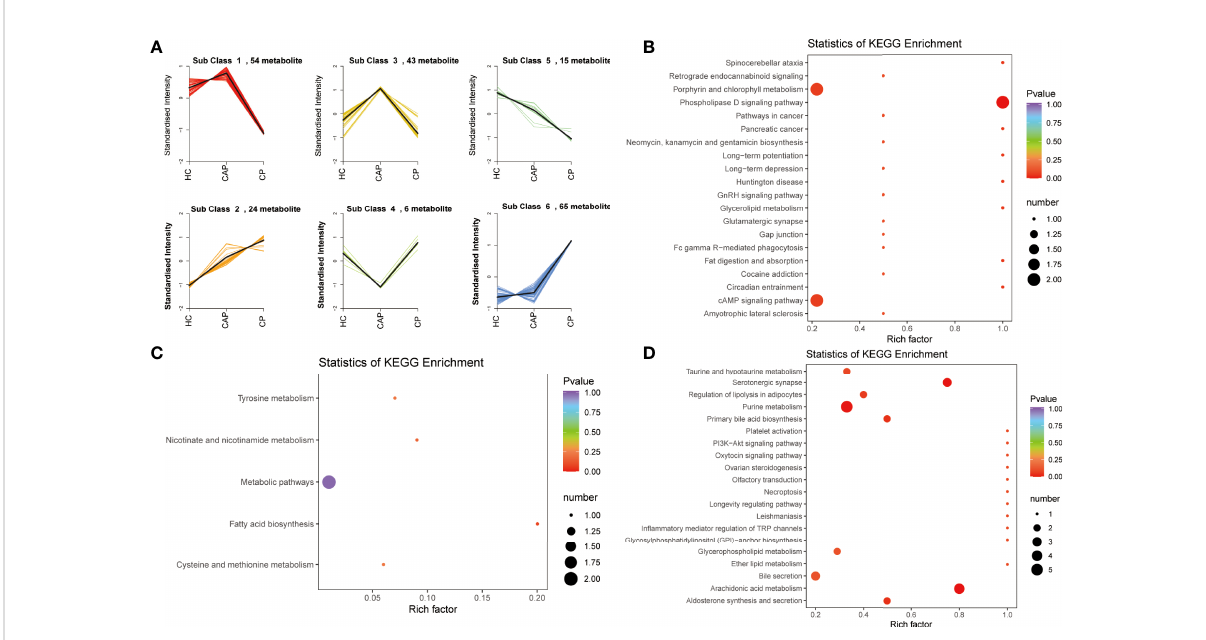
FIGURE 5 K-mean clustering analysis and pathway enrichment analysis. (A) K-means clustering analysis of differentially expressed metabolites across different groups. (B) KEGG enrichment analysis of metabolites in subcluster 2. (C) KEGG enrichment analysis of metabolites in subcluster 5. (D) KEGG enrichment analysis of metabolites in subcluster 6. HC, healthy control; CAP, community-acquired pneumonia; CP, COVID-19